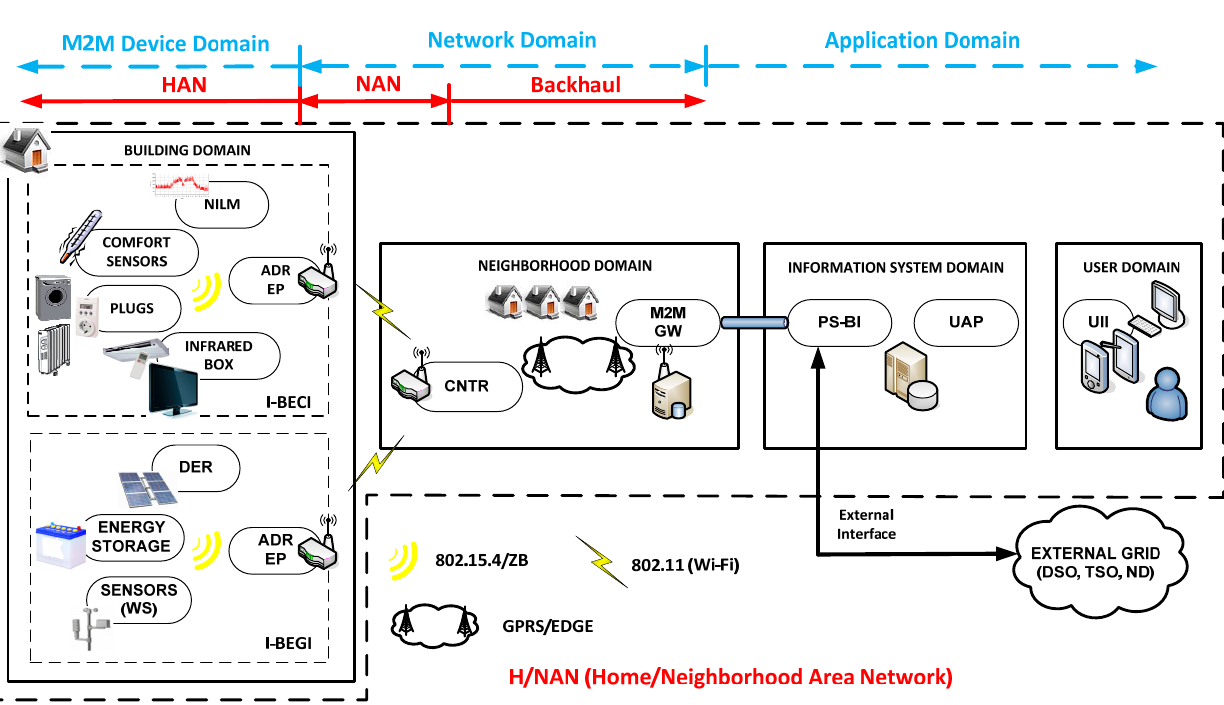
Figure 7. Overall system architecture, highlighting the relation with the standardization work reviewed in Section